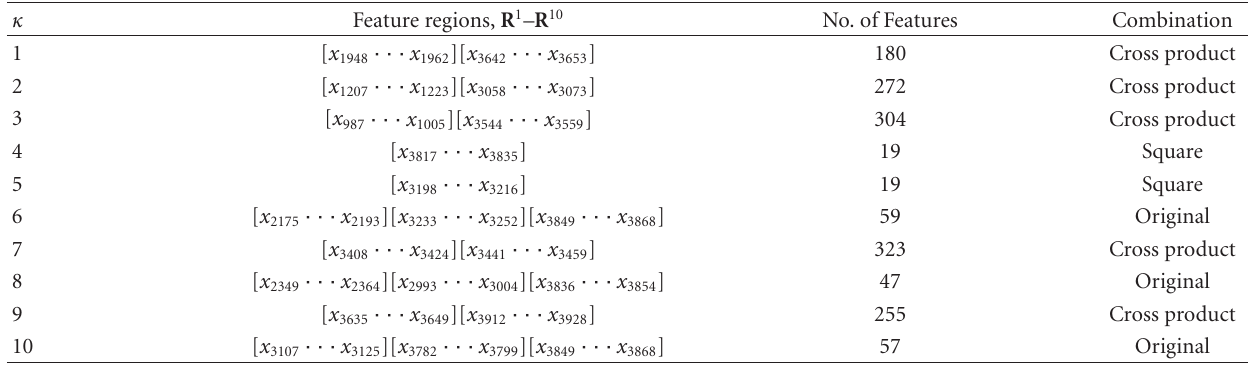
Table 3: Discriminatory feature regions selected by FLND.